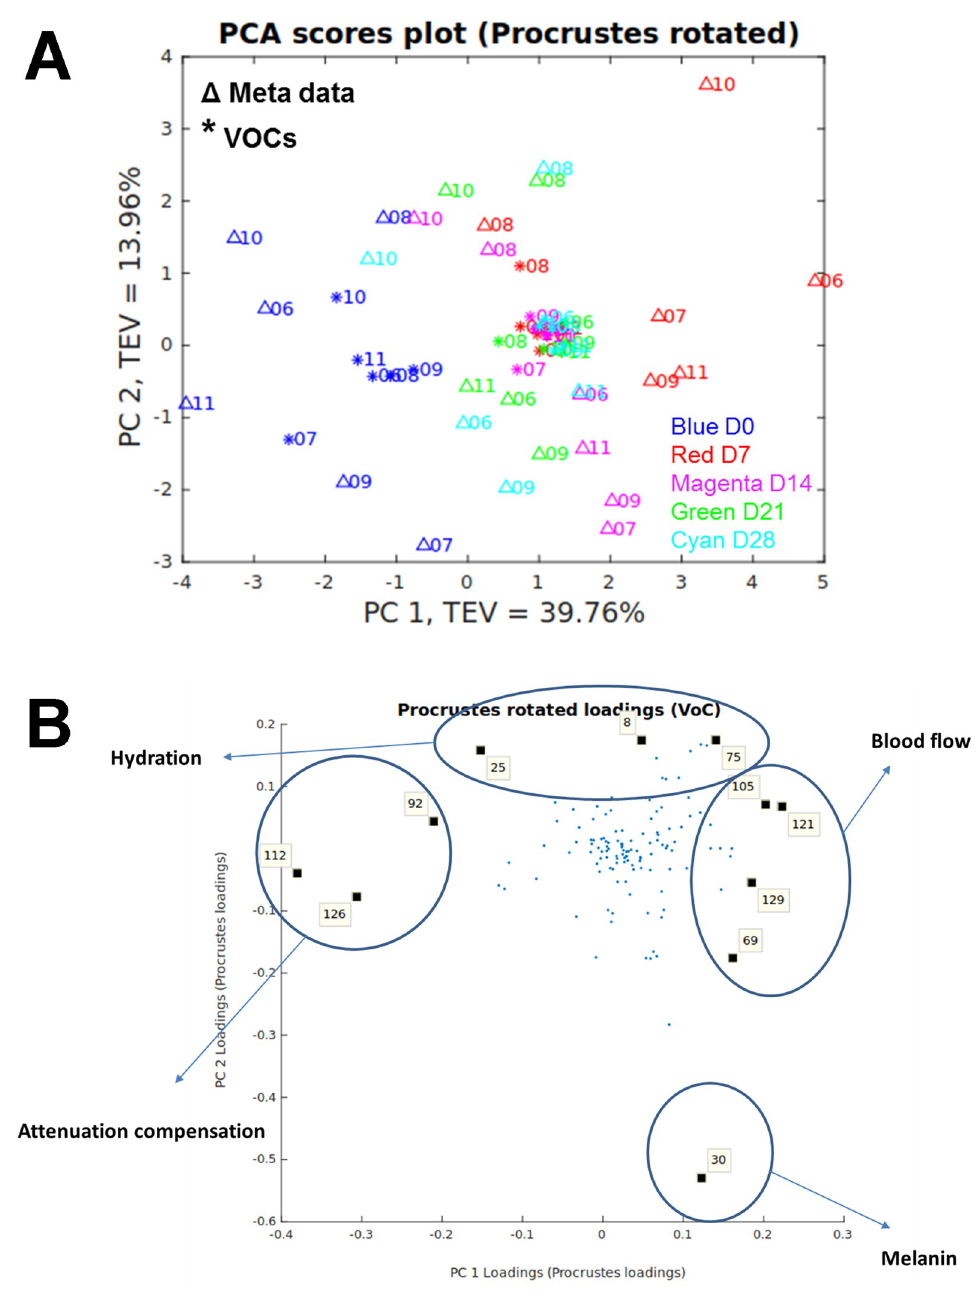
Fig 6. Procrustes analysis of non-invasive measures and wound headspace metabolome. (A) Procrustes rotated plot with a Procrustes distance of 0.7803; P = 0.0016. (B) Procrustes rotated loadings plot highlighting metabolites mostly correlated to the non-invasive measures. 8, 25, 30, 69, 75, 92—unknown; 105–1,5-dimethyl-2-oxabicyclo[3.2.1] nonan- 7-one; 112–1,3-bis(1,1-dimethylethyl) benzene; 121, 126 –unknown;